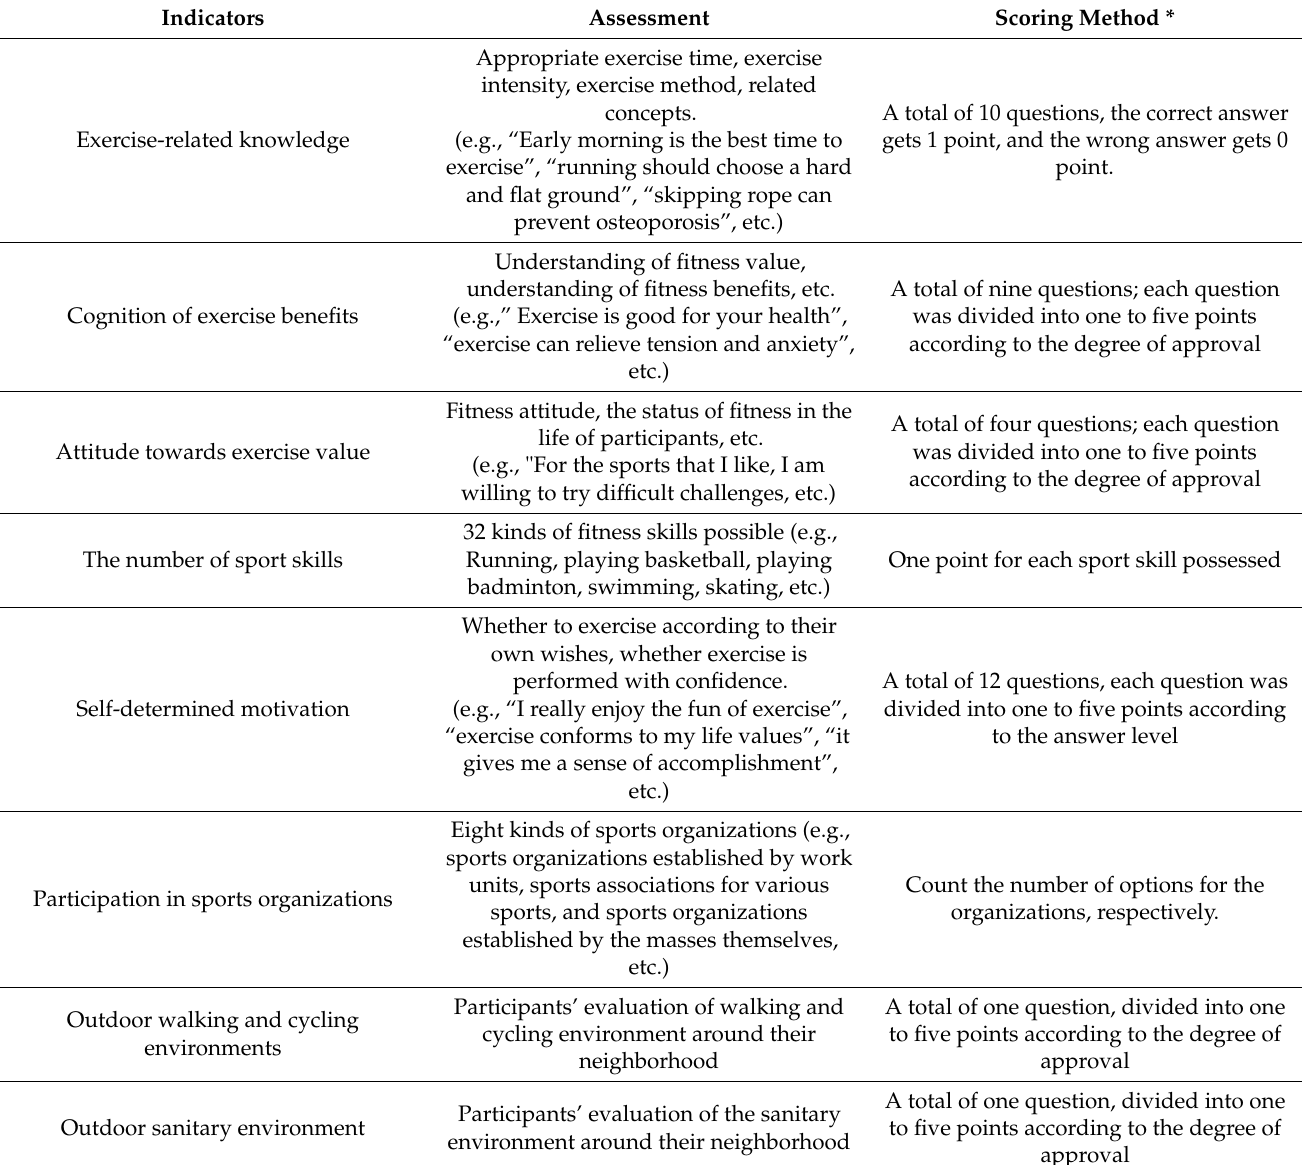
Table 1. Scoring methods of questionnaire